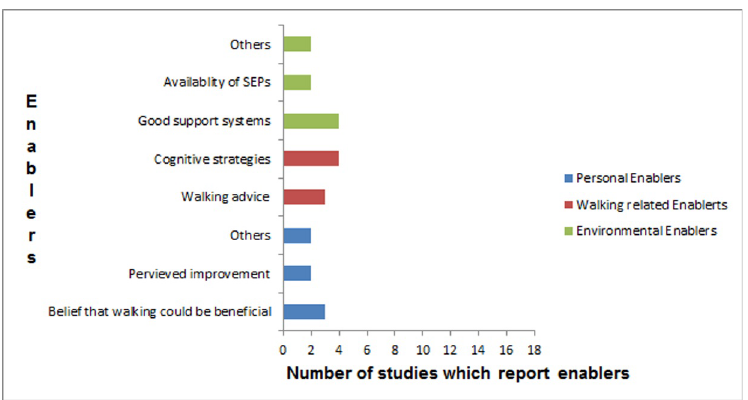
Fig 3. Enablers to walking in individuals with intermittent claudication and number of studies which reported